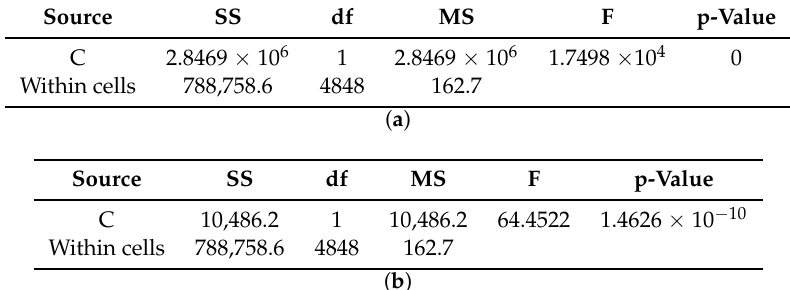
Figure A31. ANOVA tables for the analysis of the effect of factor C (amount of biased observations) on the convergence. ( a ) One-way ANOVA for factor C given B = 1. ( b ) One-way ANOVA for factor C given B = 2.